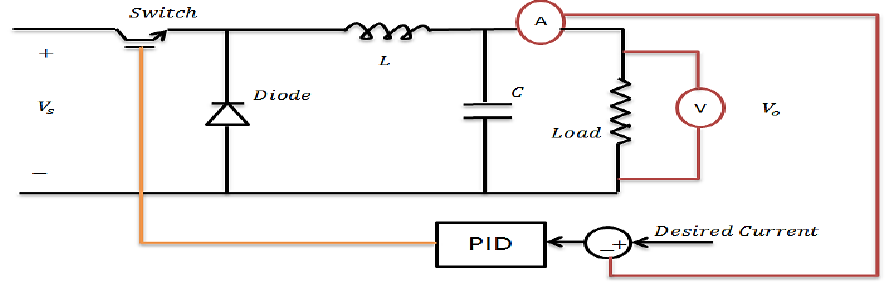
Figure 5. DC/DC Current Controlled Converter.